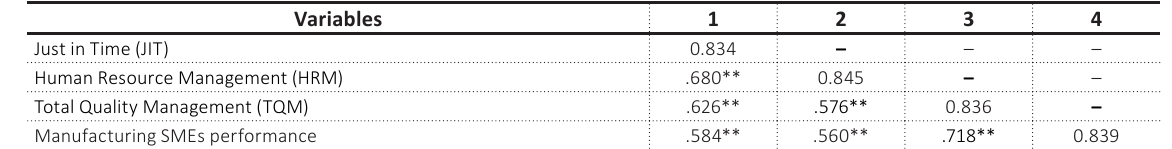
Table 3. Descriptive statistics and